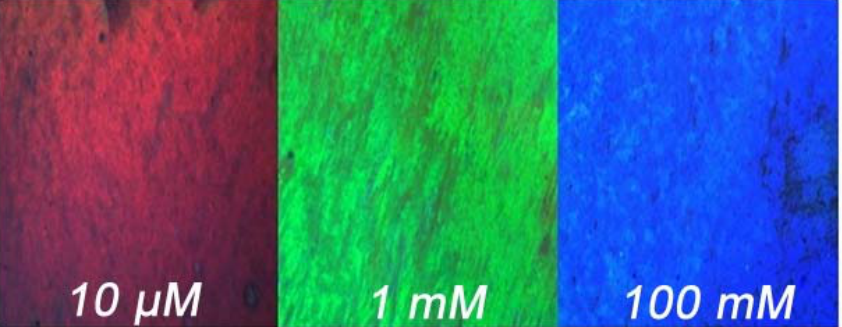
Figure 4. Microscope images (50-fold enlargement) of the photonic crystal film immersed into water solutions of KCl in varying